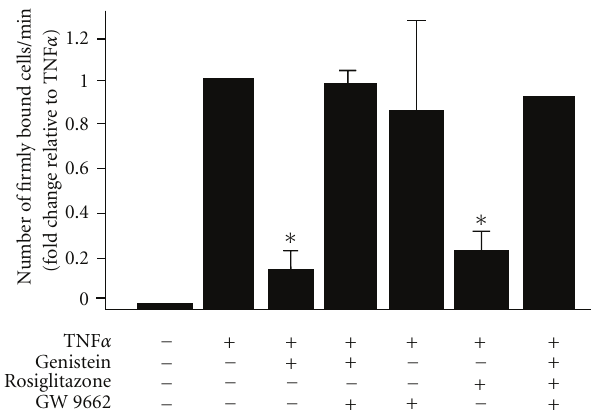
Figure 4: Isoflavones inhibit TNF α -induced monocyte adhesion to the vascular wall via activation of PPAR γ . Both genistein (1 μ M) and rosiglitazone (2 μ M) significantly reduced TNF α - induced monocyte adhesion to the vascular wall compared to TNF α alone. This inhibition was reversed by the PPAR γ antagonist, GW 9662 (5 μ M), revealing that genistein’s inhibitory e ff ect was PPAR γ dependent (reproduced with permission by the American Journal of Physiology